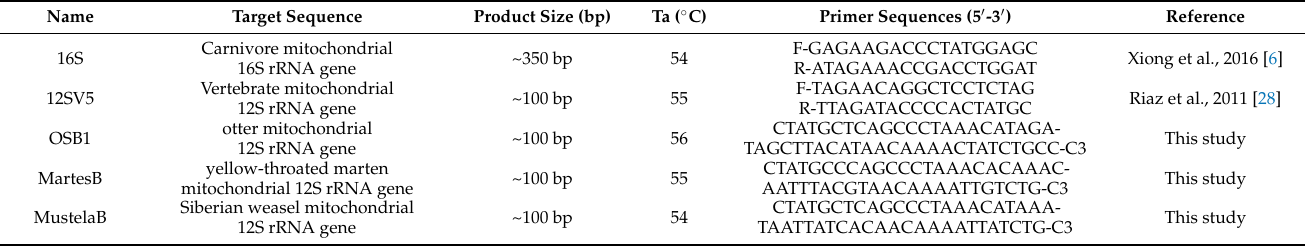
Table 1. Sequences of the primers used in this study. Product sizes do not include the primer